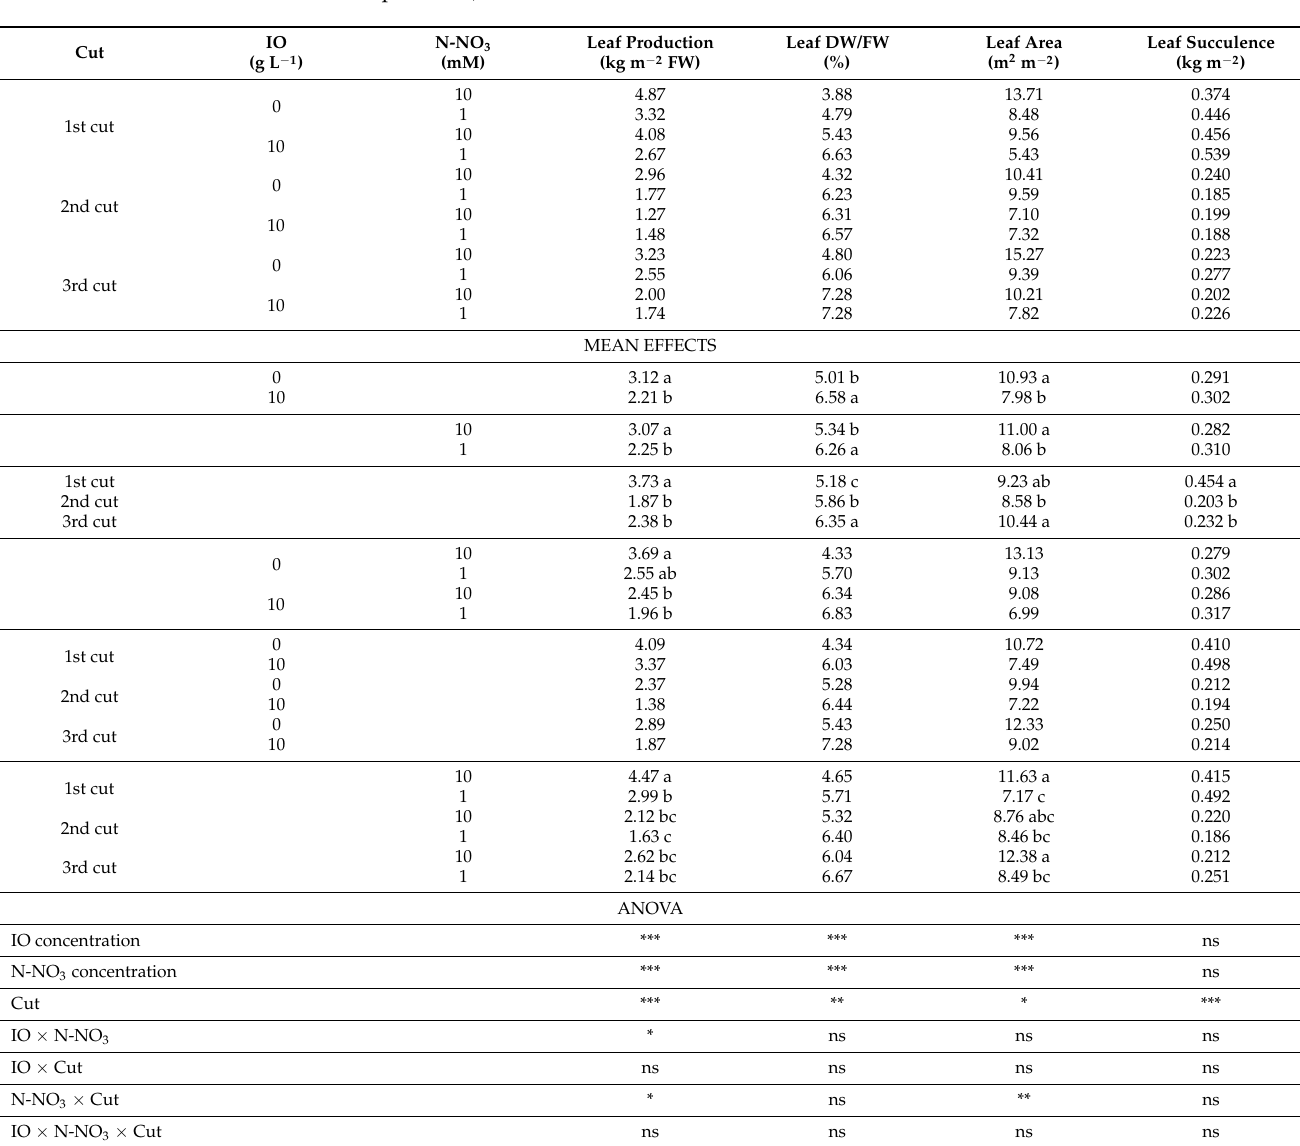
Table 5. Leaf production (fresh weight, FW), dry weight/fresh weight ratio (DW/FW), leaf area and succulence of Swiss chard plants grown hydroponically with different concentrations of the sea salt Instant Ocean (IO; 0 and 10 g L − 1 ) and nitrogen (1 and 10 N-NO 3 mM) in the nutrient solution. The leaves were harvested trice during the experiment (see Table 1 for more detailed information on the